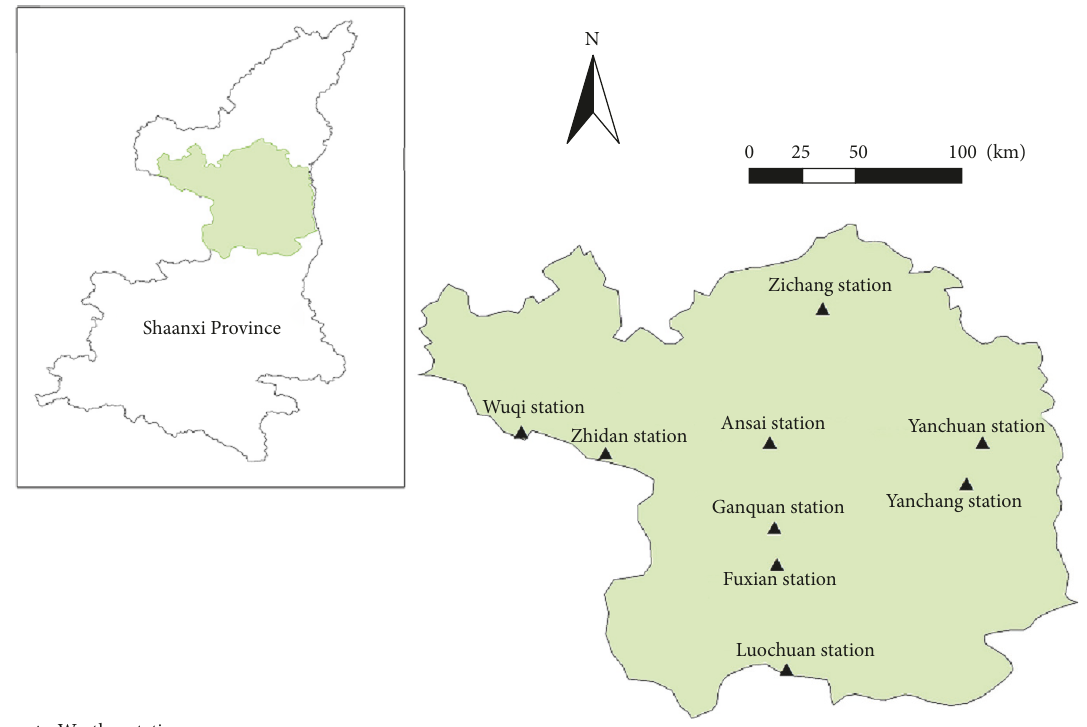
Figure 1: Spatial distribution of the nine weather stations in the Yan’an area.